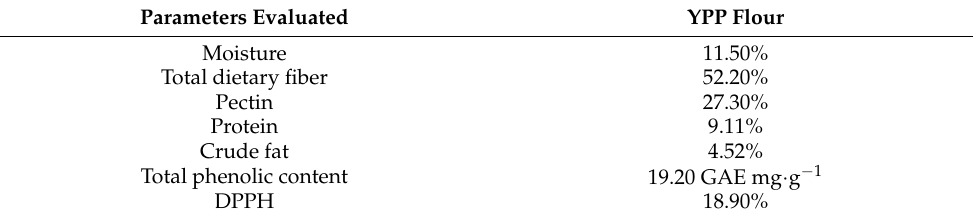
Table 2. Proximate composition of yellow peach peel (YPP)